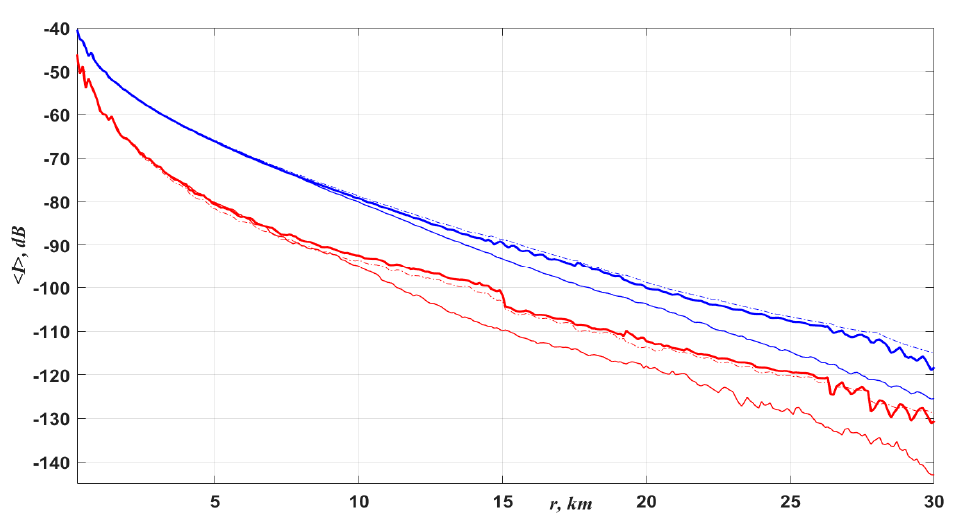
Figure 5. Transmission loss for a waveguide with Gaussian fluctuations ε and with non-Gaussian fluctuations in the form (14) with telegraph process ε 2 ( r ); L z = 20 m, L r = 4 km. Parameters of the bottom: c 1 = 1530 m/s, ( ρ 1 / ρ 0 ) = 1.5, β 1 = 0.01. H - z 0 = 42 m. Blue curves: H - z = 42 m; red curves: H - z = 26 m. Bold curves are the telegraph process ε 2 ( r ), dash curves are the adiabatic approximation, thin curves are similar to ones in Figure 3, correspond to Gaussian fluctuations.